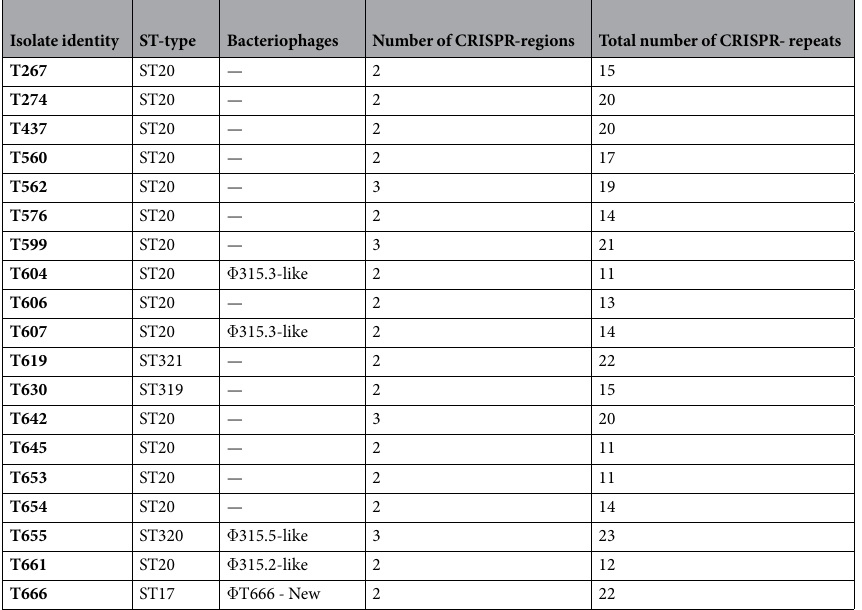
Table 3. Distribution of bacteriophages and CRISPRs. CRISPR, Clustered Regularly Interspaced Short Palindromic Repeats. The symbol – denotes the absence of bacteriophages.